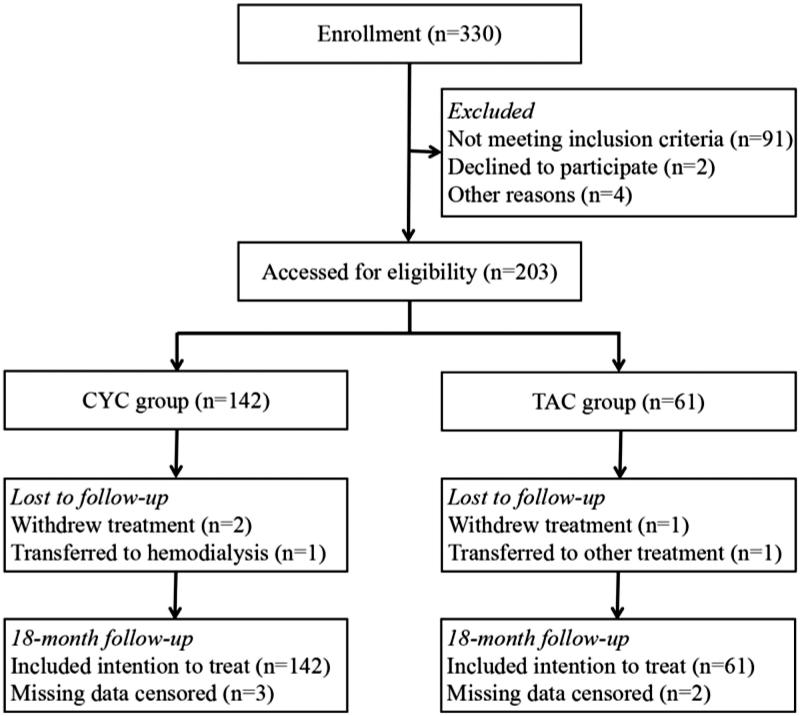
Flow diagram for inclusion of participants. CYC: cyclophosphamide; TAC: tacrolimus.